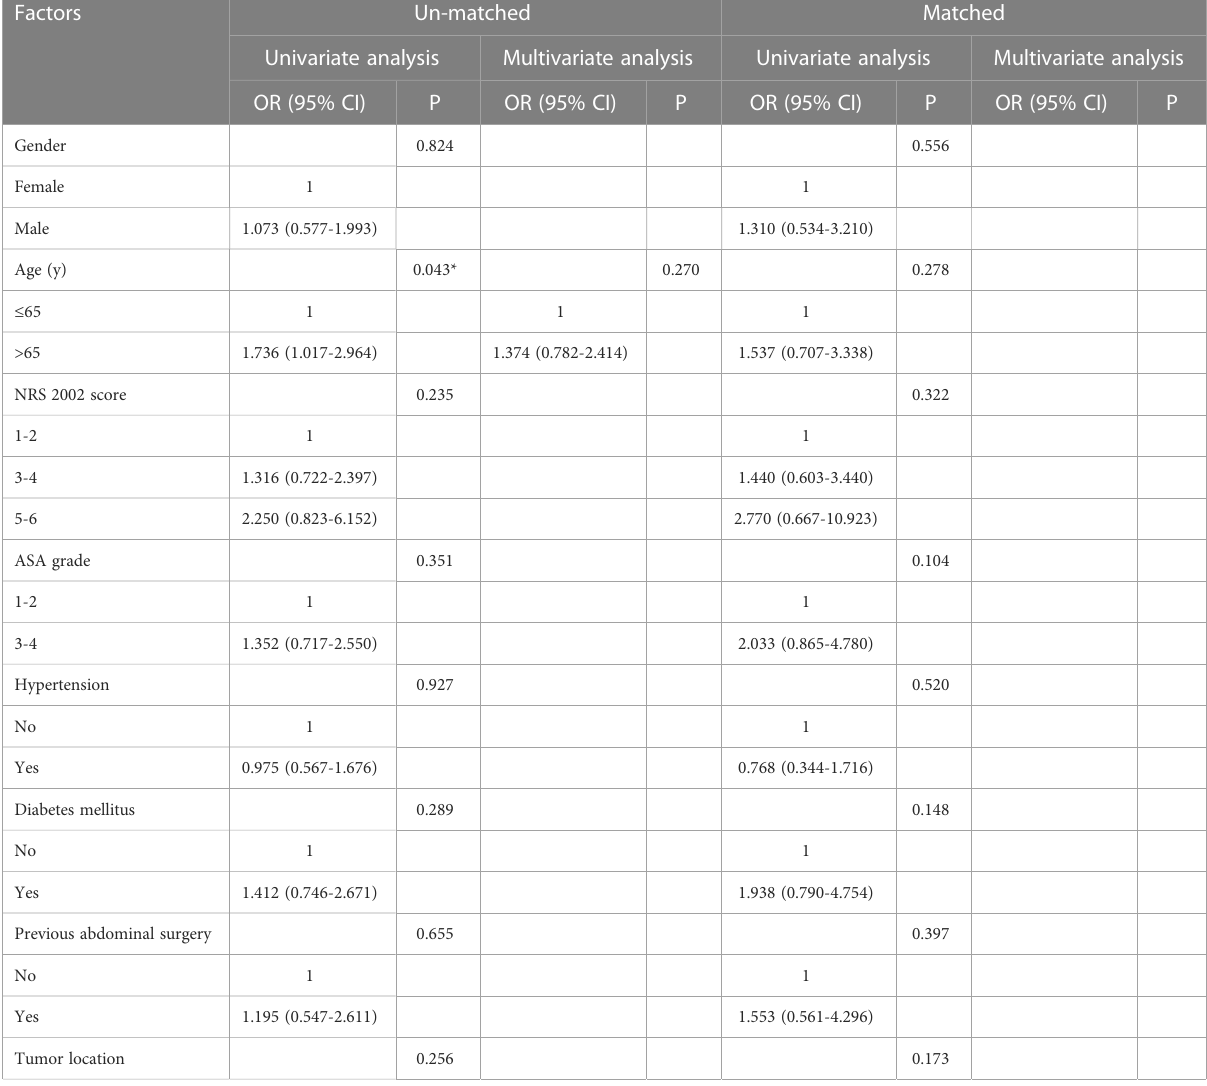
TABLE 4 Univariate and multivariate logistic analysis of factors associated with total postoperative